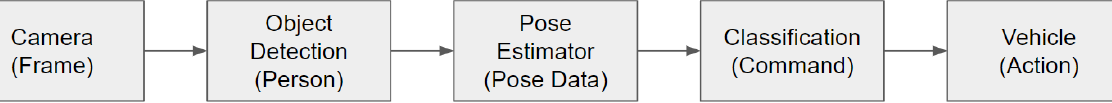
Figure 5. Our pipeline for gesture recognition and the resultant actions by the vehicle. This diagram is formatted as Component (Returns) . The camera returns a frame, and the object detection takes the frame and returns a cropped photo of the person it is currently targeting. The pose estimation then uses this to return the estimated pose data. This is then given to the classifier, which predicts a command that is then sent to the vehicle, which finally performs an action.